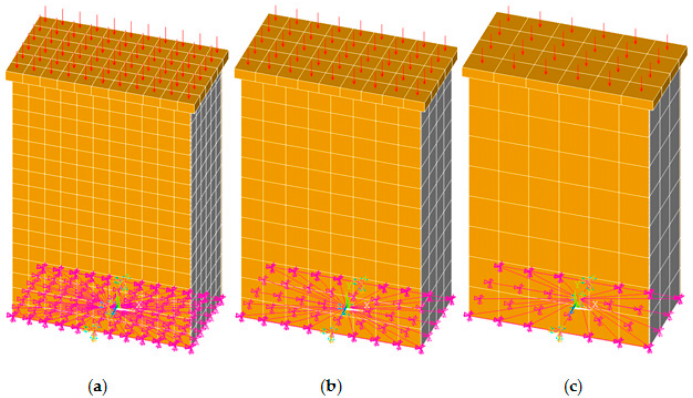
Figure 9. Computational model finite element grid, loading and support conditions ( a ) Mesh A ( b ) Mesh B ( c ) Mesh C.